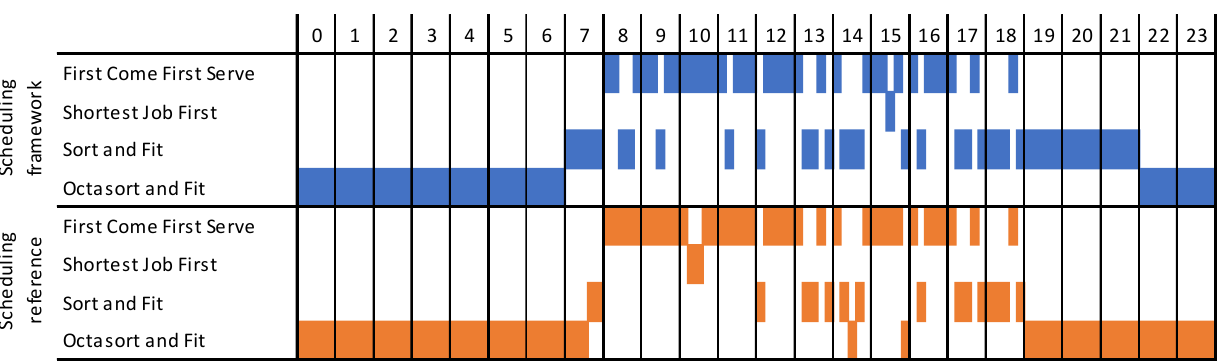
Figure 15. Comparison between the sampled scheduling framework and the scheduling reference.